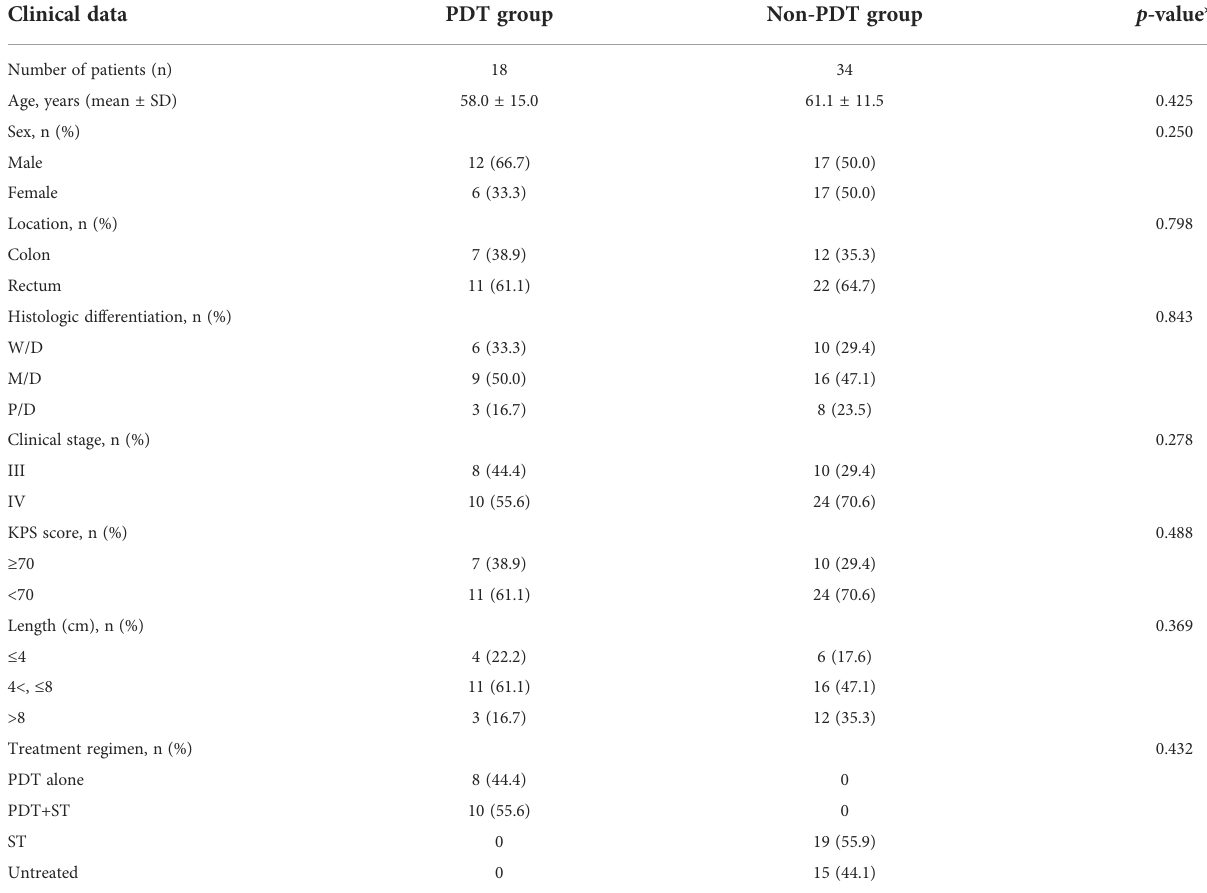
TABLE 1 Clinical characteristics of 52 CRC